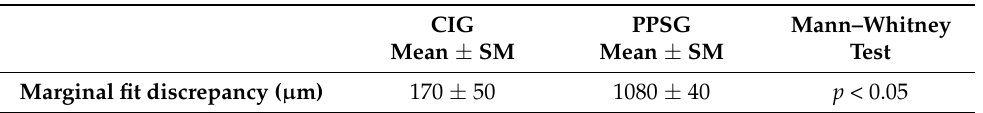
Table 1. Marginal fit discrepancy between the conventional impression group (CIG) and provisional prosthesis scanning group